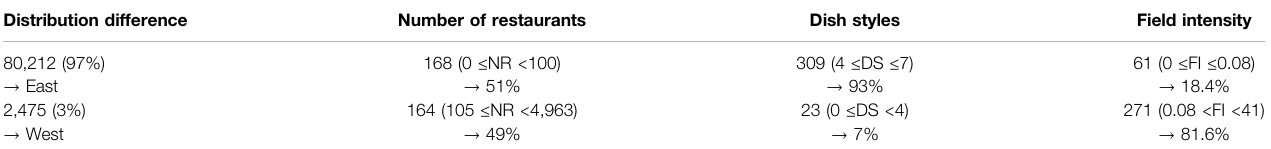
TABLE 2 | Differences in restaurant dish styles and fi eld intensity.